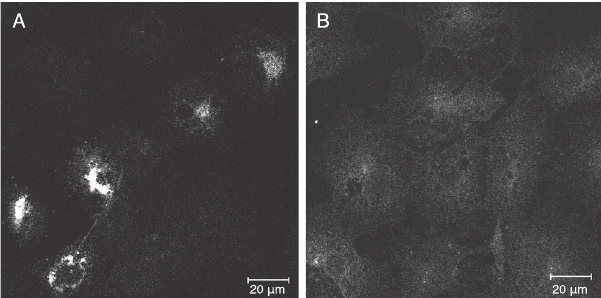
Figure 6. Immunocytochemical analysis of PC1 C-terminus in COS7 cells. COS7 cells, expressing transfected full length PC1, were chemically fixed with 2% PFA/PBS and then treated with and without the detergent, Triton X-100. PC1 was stained with C-terminal specific immunopurifed IgGs by indirect immunofluorescence. In the Triton X-100 treated cells, a strong staining pattern of the C-terminus of PC1 was observed in the transfected cells consistent with a distribution in the reticular network of the ER and in the Golgi ( A ). Only a low level of background staining was observed for the TX-100 untreated cells ( B ). Bar 20 m